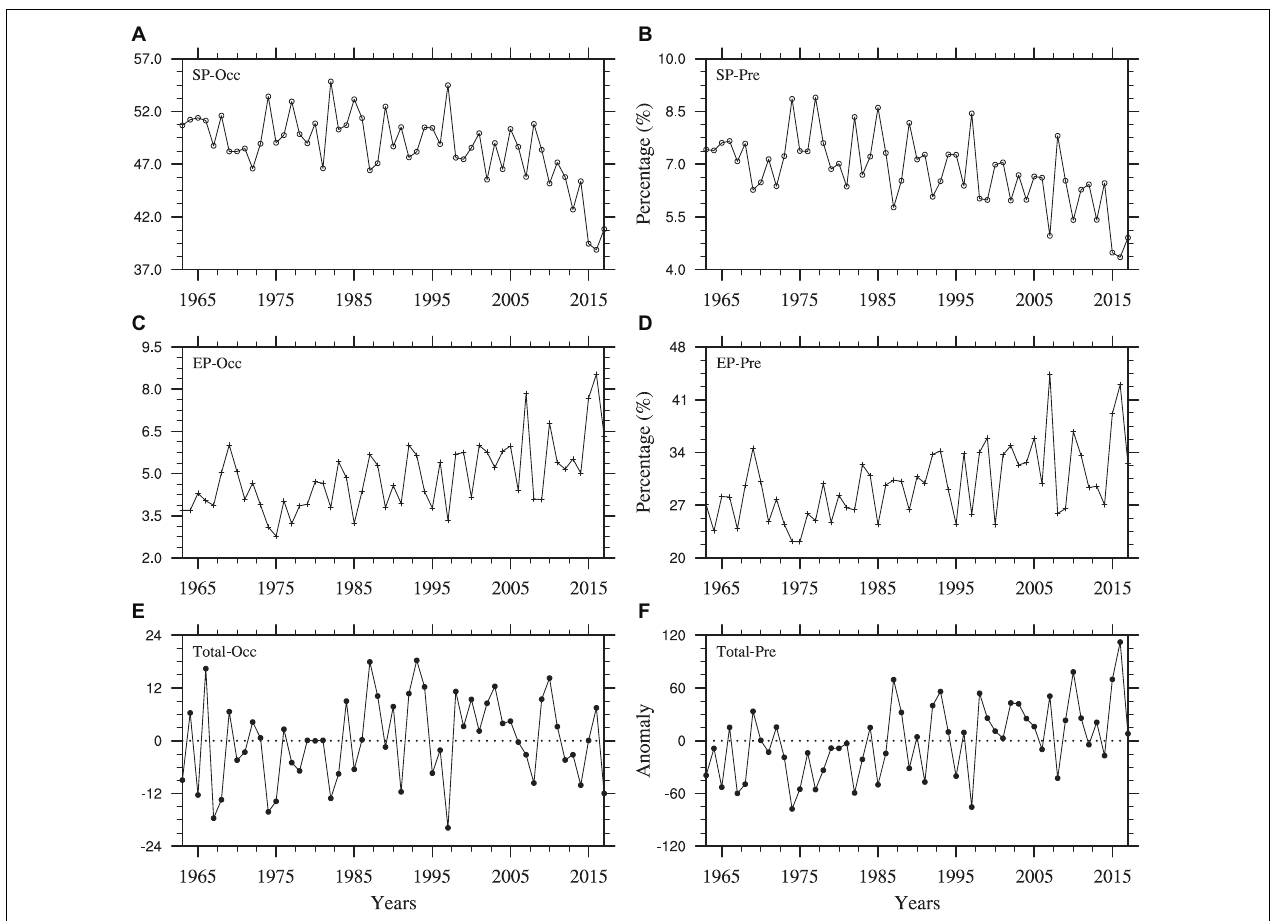
FIGURE 4 | The regionally averaged contribution of SP and EP events (A,C) to the total number of annual wet days: (A) SP, and (C) EP; and (B,D) to the total annual precipitation amount: (B) SP, and (D) EP; (E) anomalies in the regionally averaged total number of annual wet days; (F) anomalies in the regionally averaged total annual precipitation amount. Plotted data are the means calculated over all 25 stations across Northern Xinjiang from 1963 to